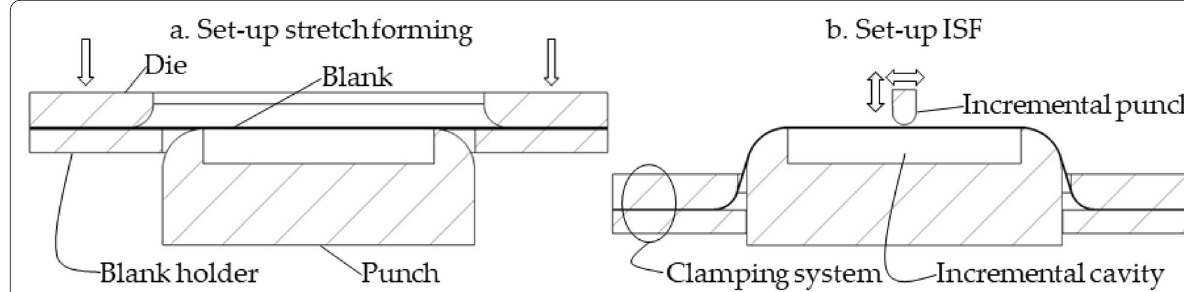
Figure 4 Equipment setup for both processes